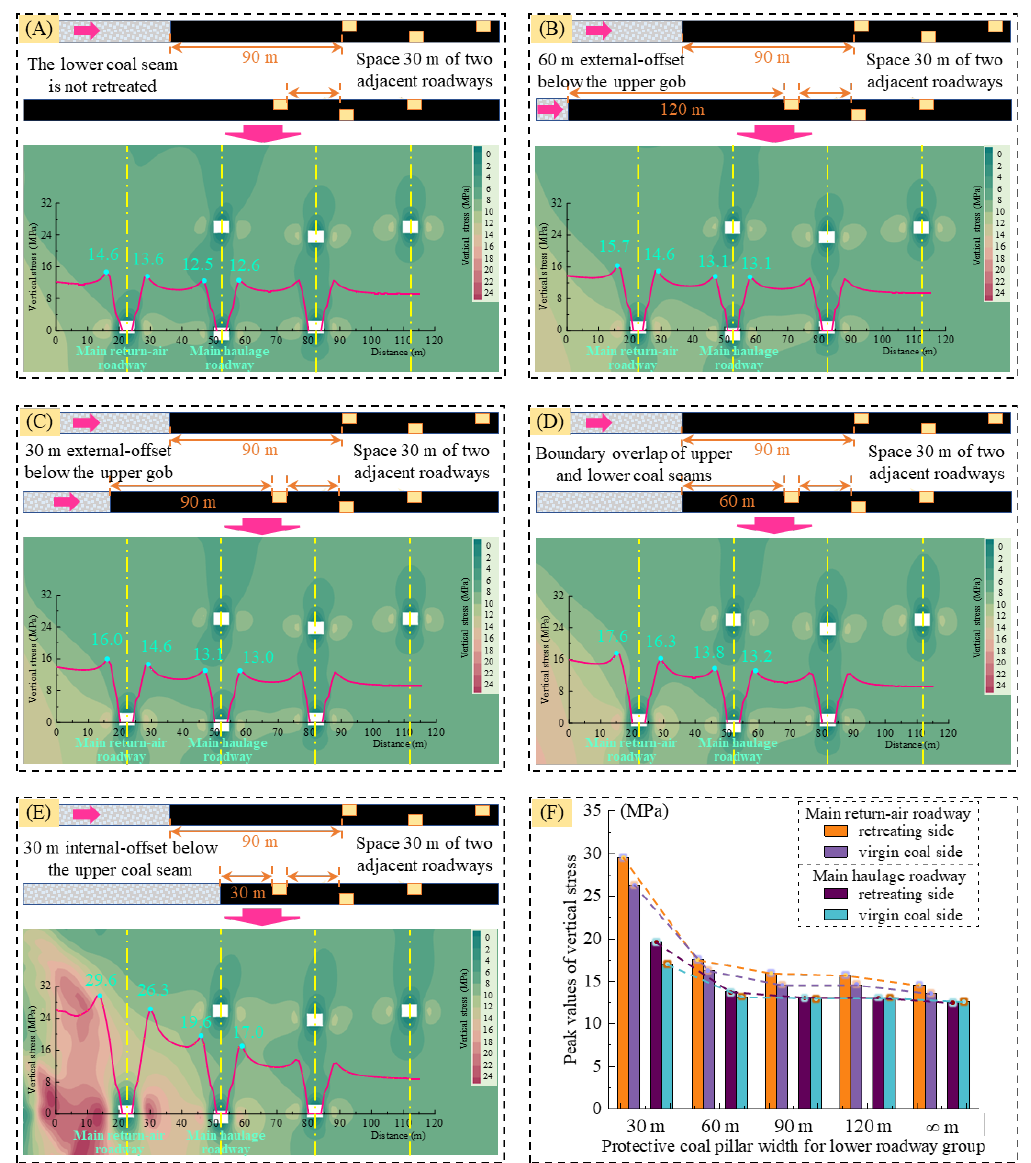
Figure 11. Stress evolution process of the main roadway group during the lower coal seam recovery.